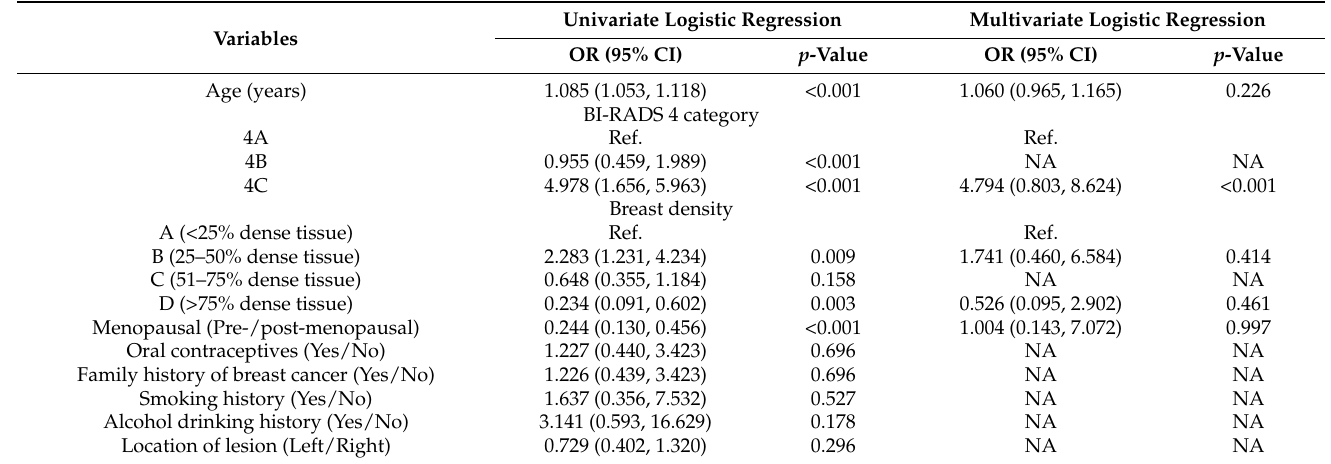
Table 2. Results of the univariate and multivariate logistic regression analyses based on the training group.